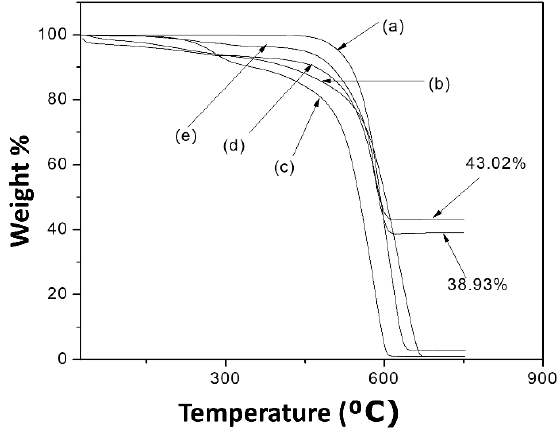
Figure 4. TGA of ( a ) MWCNT, ( b ) MWCNT-COOH, ( c ) MWCNT-ODA, ( d ) p-MWCNT-Pd, and ( e ) np-MWCNT-Pd.